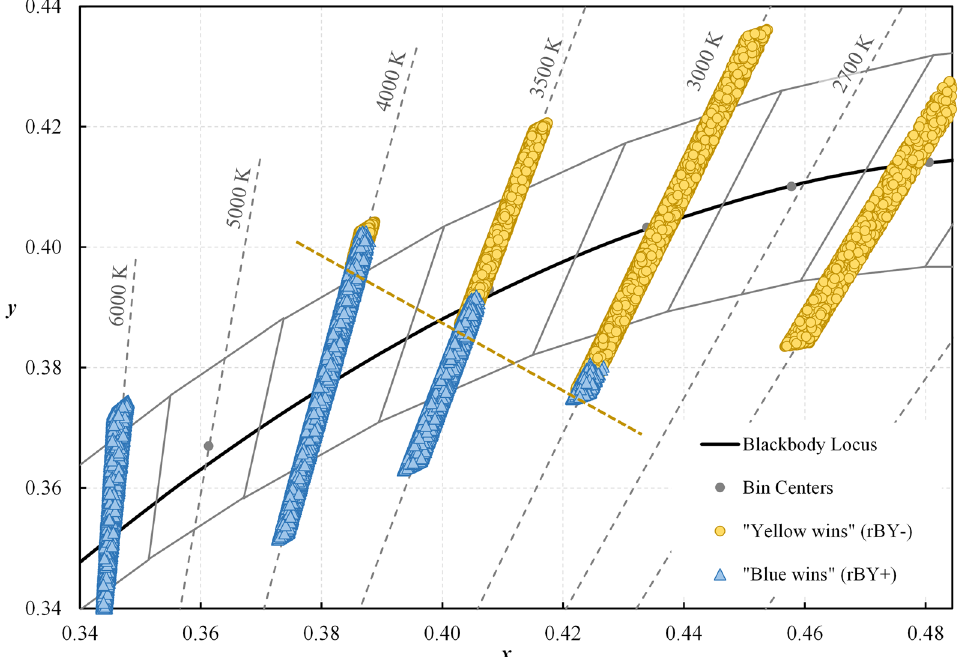
Figure 10. Chromaticity of the “Full” dataset, filtered for R f ≥ 70, plotted in the CIE 1931 ( x , y ) chromaticity diagram. The b-y spectral opponency of the CS model manifests strongly in chromaticity space cutting the 3500 K and 4000 K Basic ANSI quadrangles diagonally. The yellow dashed line indicates the limit of the “yellow wins” dataset (circle markers) which is hidden by the “blue wins” dataset (triangle markers). When this line representing the boundary of the b-y spectral opponency is extended, it intersects the spectrum locus near 500 nm which is near the crossover wavelength of the functions that the CS model uses to determine “blue wins” (rBY+) or “yellow wins” (rBY-).